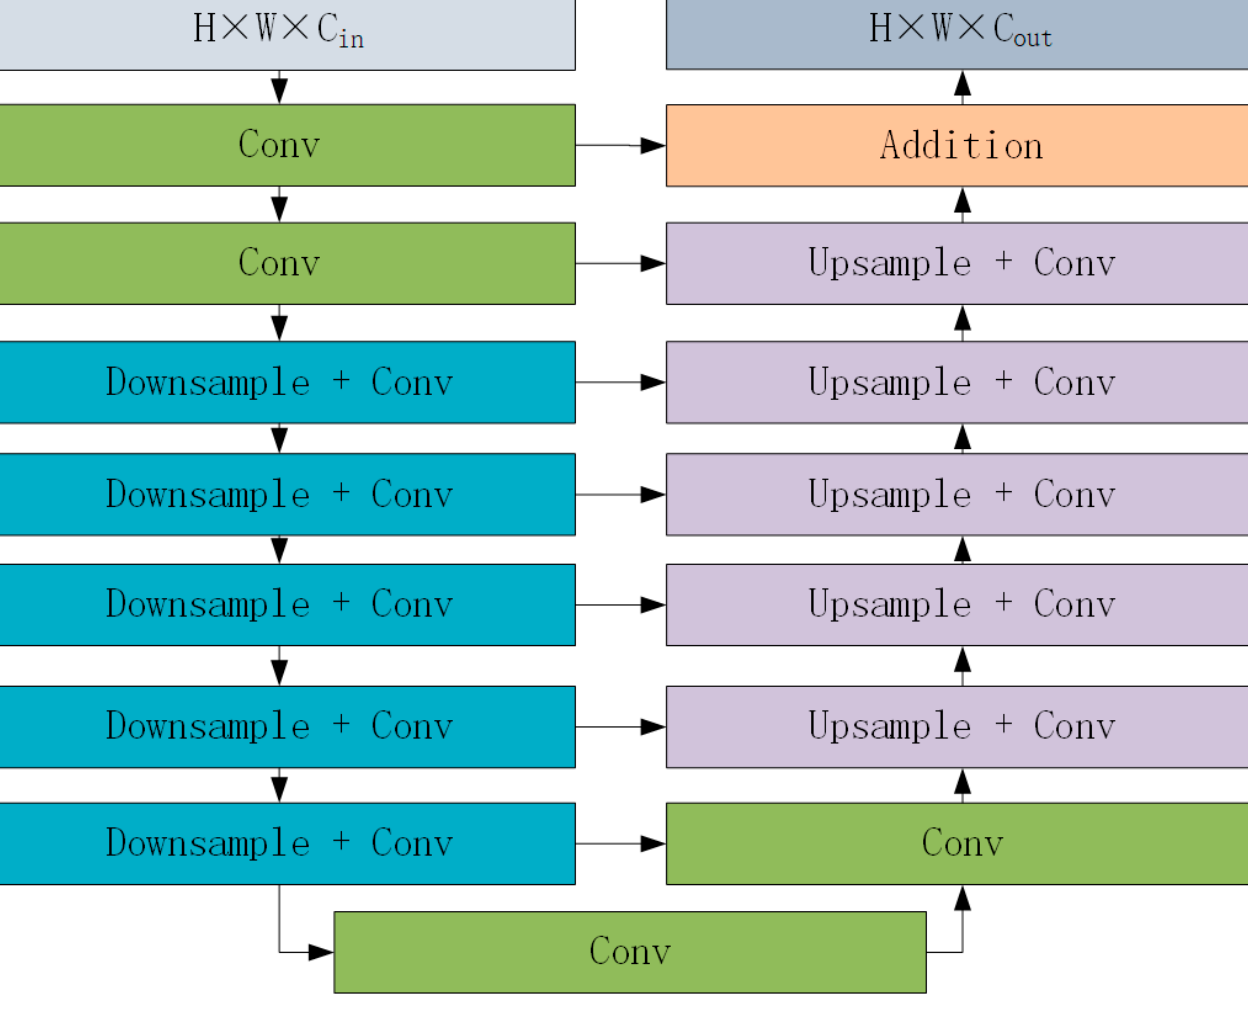
Figure 4. Residual U-blocks (RSU) [69].